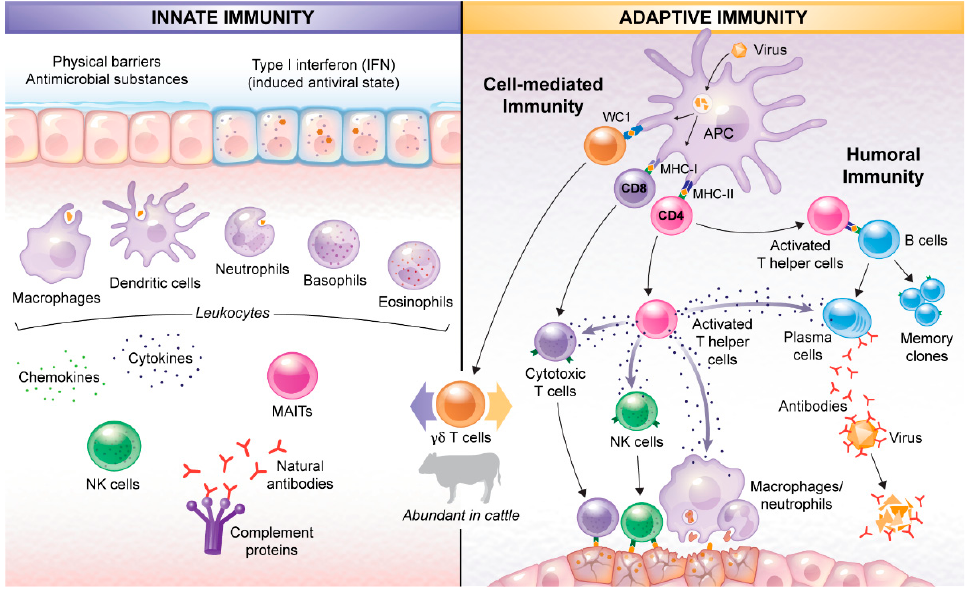
Figure 1. The bovine immune system. The innate immunity mainly involves epithelial barriers, phagocytic cells and their chemokines and cytokines, Natural killer (NK) cells, Mucosa-associated invariant T cells (MAIT), Type I interferon and Complement proteins. The adaptive immunity con- sists of antibody production by Plasma cells (differentiated B lymphocytes) and cell-mediated im- munity handled by T lymphocytes. Gamma delta T cells are the most abundant T lymphocytes in cattle and play important roles in both innate and adaptive immune